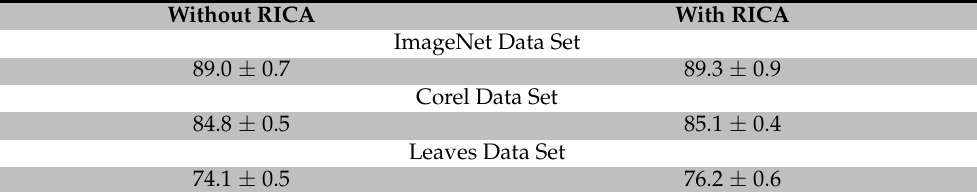
Table 4. Average accuracy of SCSA without or with RICA for three datasets (%).